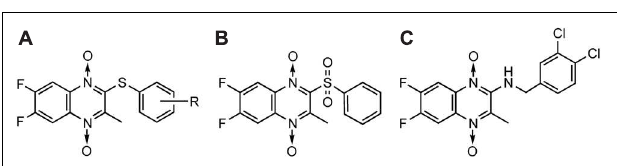
FIGURE 10 | QdNOs with antitrichomonas activity.